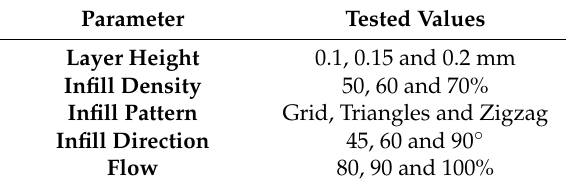
Table 4. Tested values of each analyzed parameter to obtain the best cellular growth